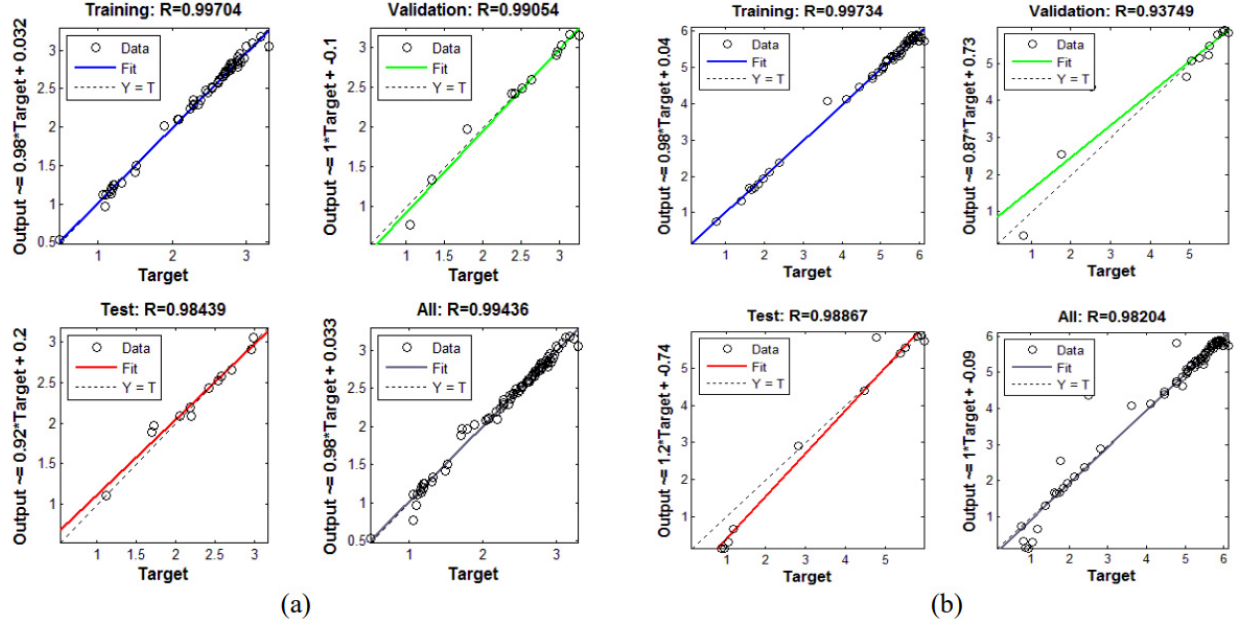
Figure 6. ( a ) Regression values for SFC data at flat surface; ( b ) Regression values for SFC data at cylindrical surface.